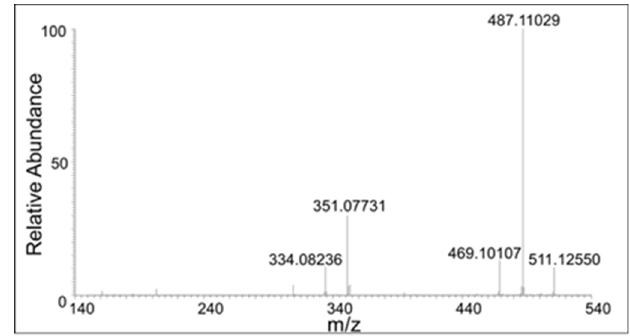
Figure 13. The CID mass spectrum of the m / z 529 mass unit ion eluting at 22 min.